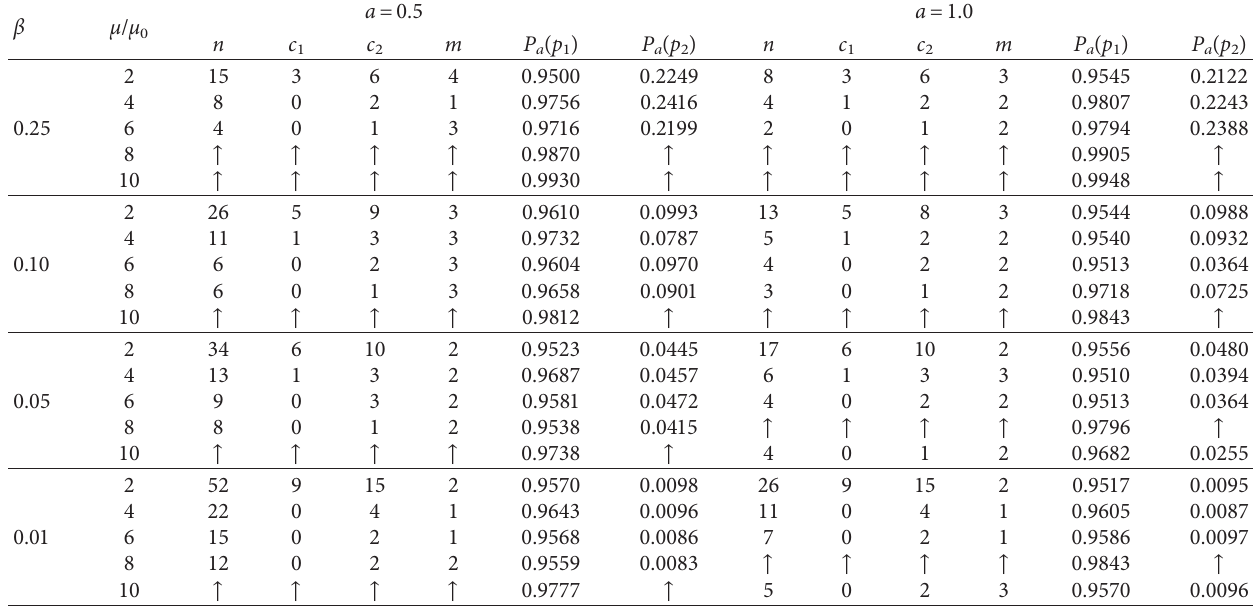
Table 4: Plan parameters of modified MDS sampling plan for Weibull distribution with δ �